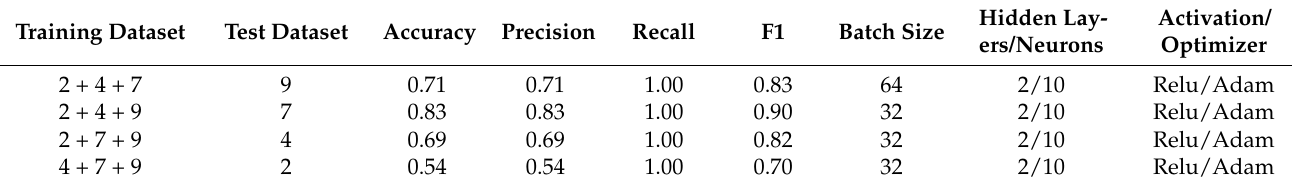
Table 9. Results of multilayer perceptron using three datasets as training